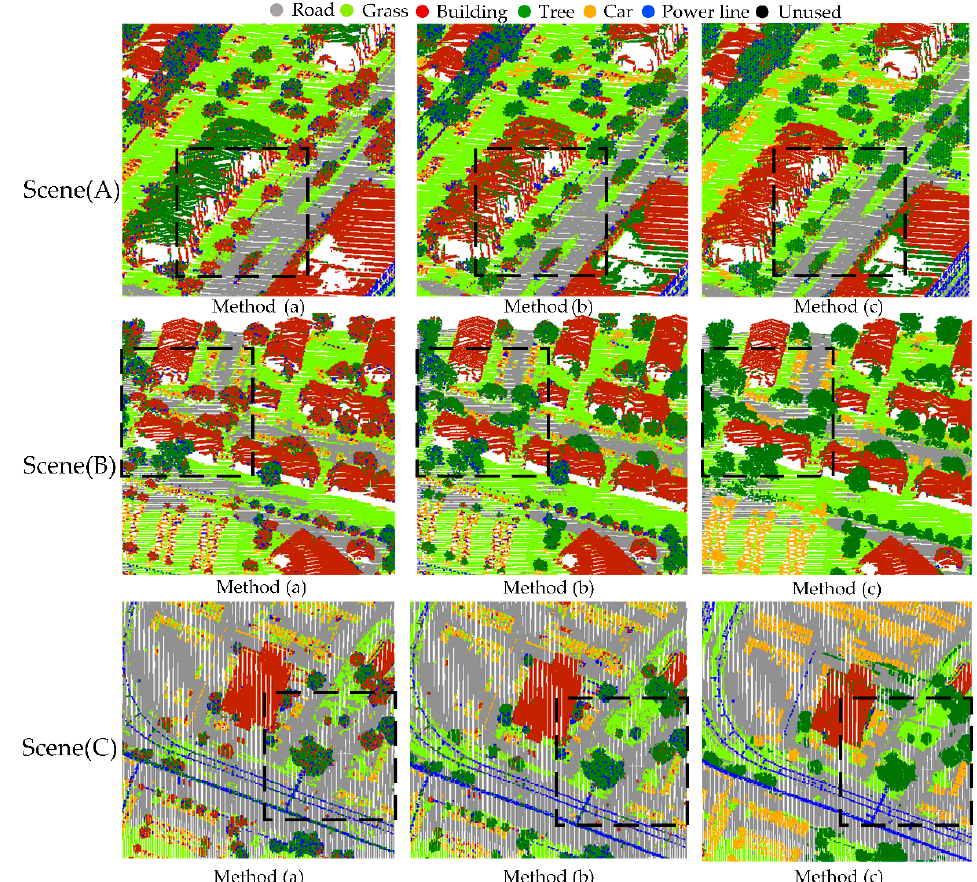
Figure 10. Comparison of the three method classifications in three